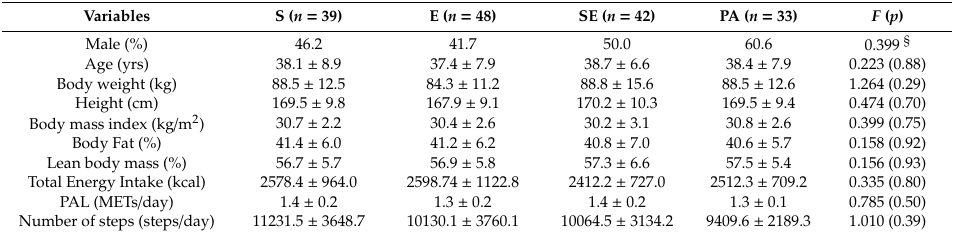
Table 1. Baseline characteristics.